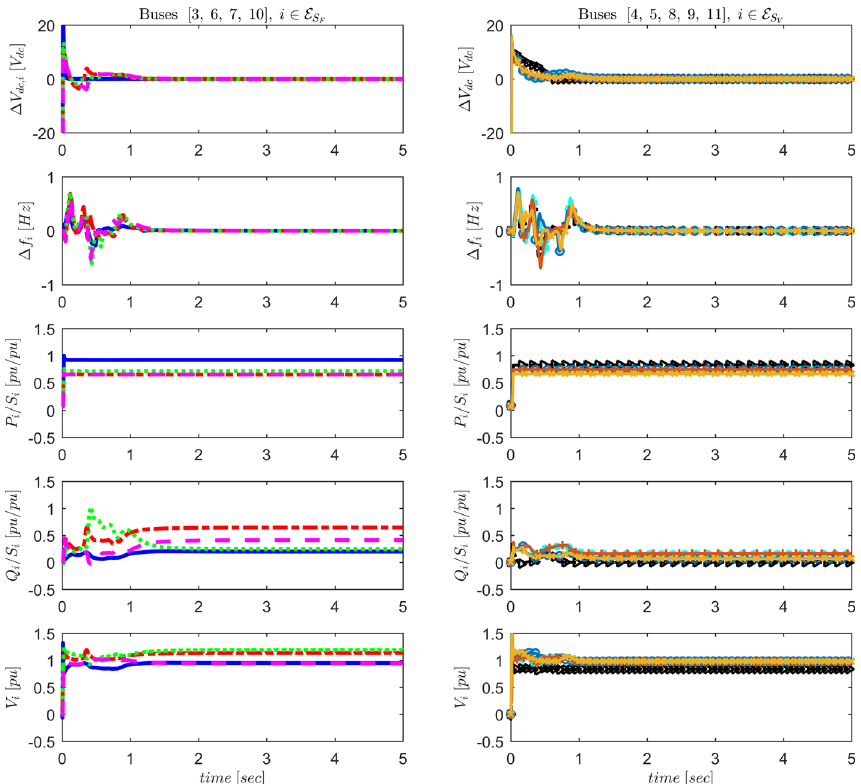
Fig. 12 Islanded scenario. The microsource dynamic responses including dc voltage tracking, frequency synchronization, the power sharing as well as ac voltage tracking (amplitudes at output terminals). The lines correspond to the grid-forming microsources i ∈ E S bus 10, ’-.’. Moreover, the lines correspond to the grid-feeding microsources i ∈ E S